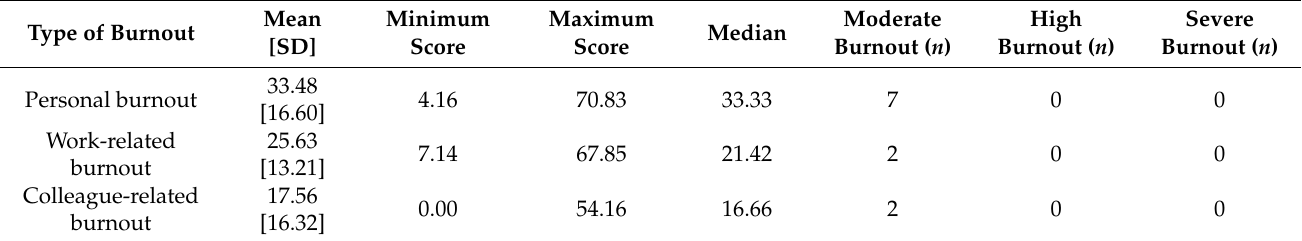
Table 2. Copenhagen Burnout Inventory ( n = 40).